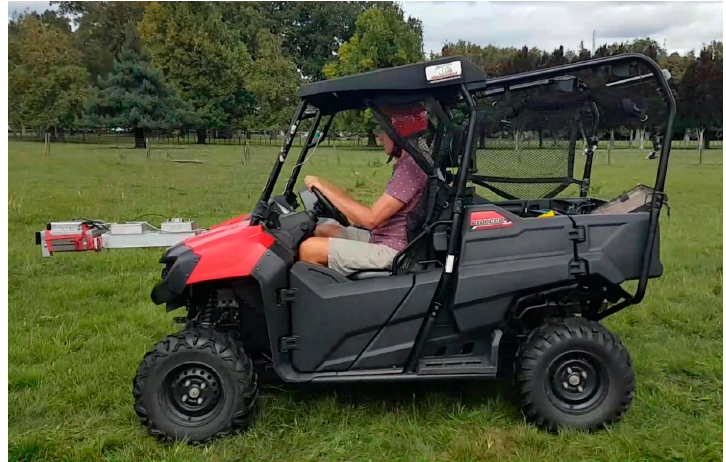
Figure 5. The farm vehicle with the ultrasonic pasture meter mounted on a frame and pointing downward at the pasture ahead of the vehicle. The ultrasonic pasture meter is at the front of the frame.